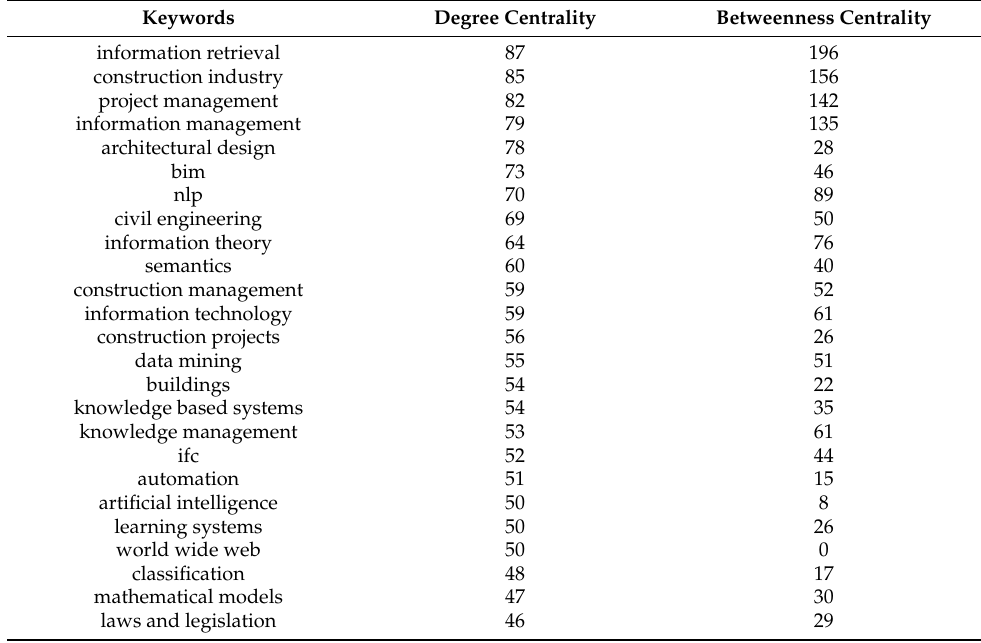
Figure 9. Relative influence of existing research via Degree Centrality ranking. Table 5. Degree Centrality and Betweenness Centrality values. Software: Gephi version 0.9.2.